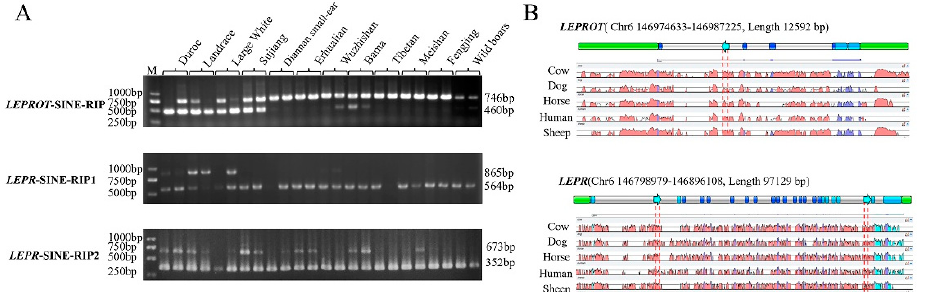
Figure 1. RIP identification and insertion loci diagram in LEPROT and LEPR. ( A ) The electrophoretogram of PCR production of three loci in LEPROT and LEPR genes in 12 breeds or population DNA pool. ( B ) Insertion loci diagram and sequence alignment for different species in LEPROT and LEPR. Table 1. The details of three RIPs in LEPROT and LEPR genes.